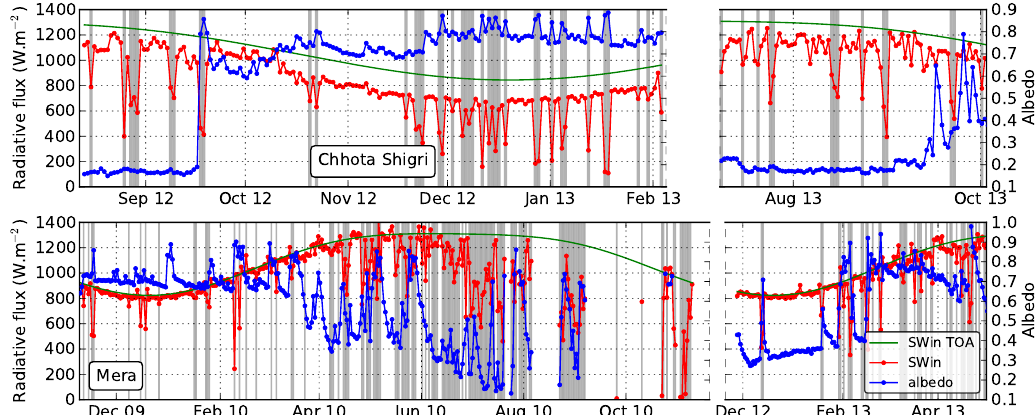
Figure 4. Measured (red) and modeled top of the atmosphere (green) incoming shortwave radiation and albedo (blue) for Chhota Shigri (top) and Mera (bottom) glaciers. The values reported are the daily maxima of the radiative flux. The daily albedo is calculated as the average of the albedo on a 2h time span centered on the satellite passing time. Note the difference in x axis scale. The vertical grey lines show the days detected as cloudy, using a threshold on incoming irradiance (see text for